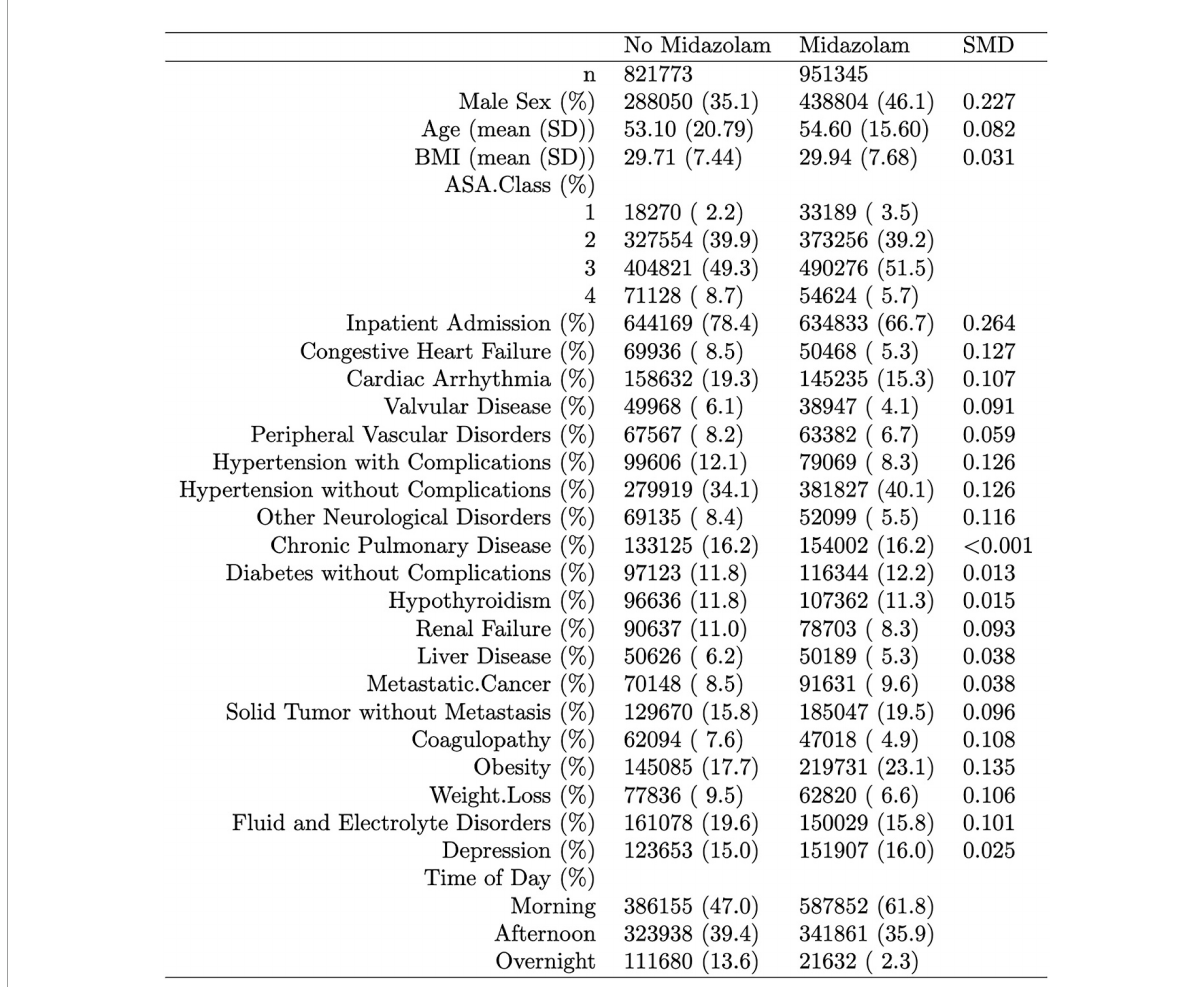
FIGURE2 Distribution of the propensity score stratified by whether subjects had perioperative midazolam. “SMD” column represents the standardized mean difference. The percentage of patients with a neuromuscular block only were 0.4% in the midazolam group and 1.6% in the non-midazolam group. The lab cTnI (ng/mL), used to define our myocardial injury in non-cardiac surgery (MINS) endpoint, was present in 4.7% of subjects in both the group with and without midazolam.